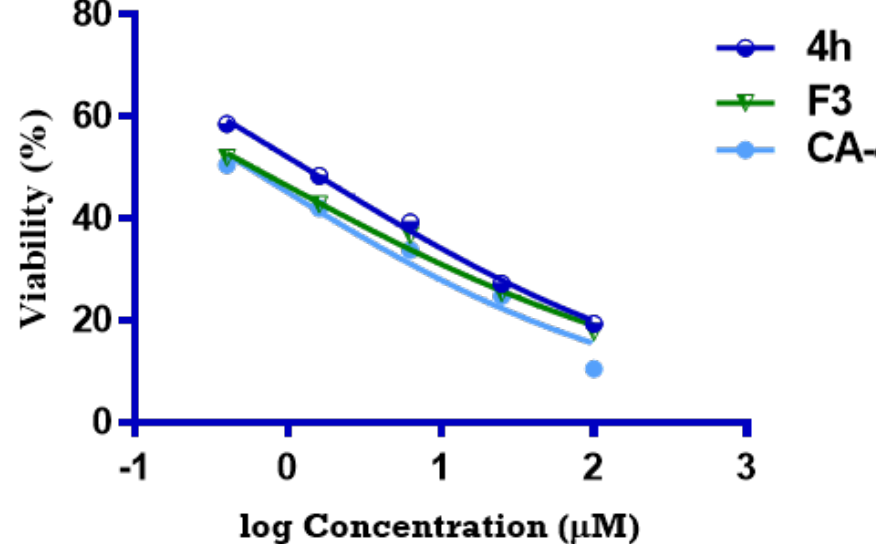
Figure 17. The graphical pattern showing the results of % cell viability of F3 versus 4h and CA-4 as reference drug at multiple concentrations (μM) on MDA-MB-231 cancer cells.